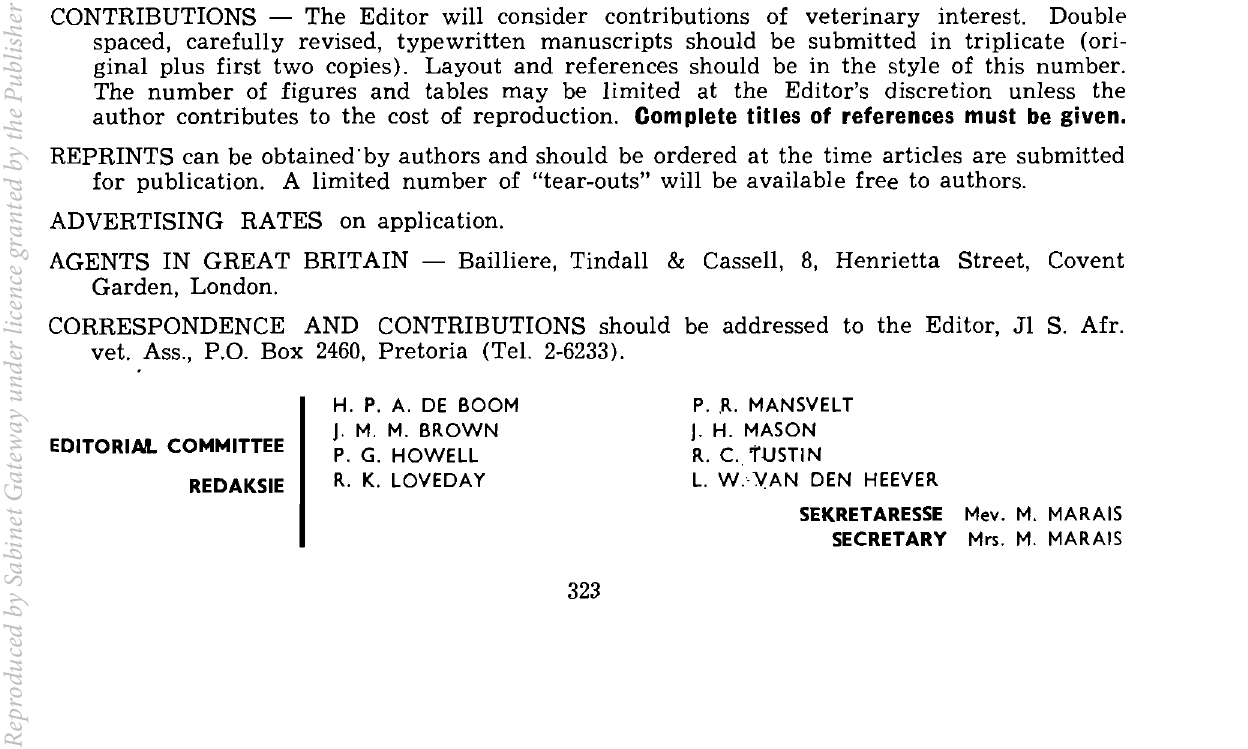
TYDSKRIF VAN DIE SUID-AFRIKAANSE VETERINERE VERENIGING THE JOURNAL OF THE S.A.V.A. is owned and published by the South African Veterinary Association, of which it is the official organ. It appears quarterly and is devoted to matters of veterinary importance